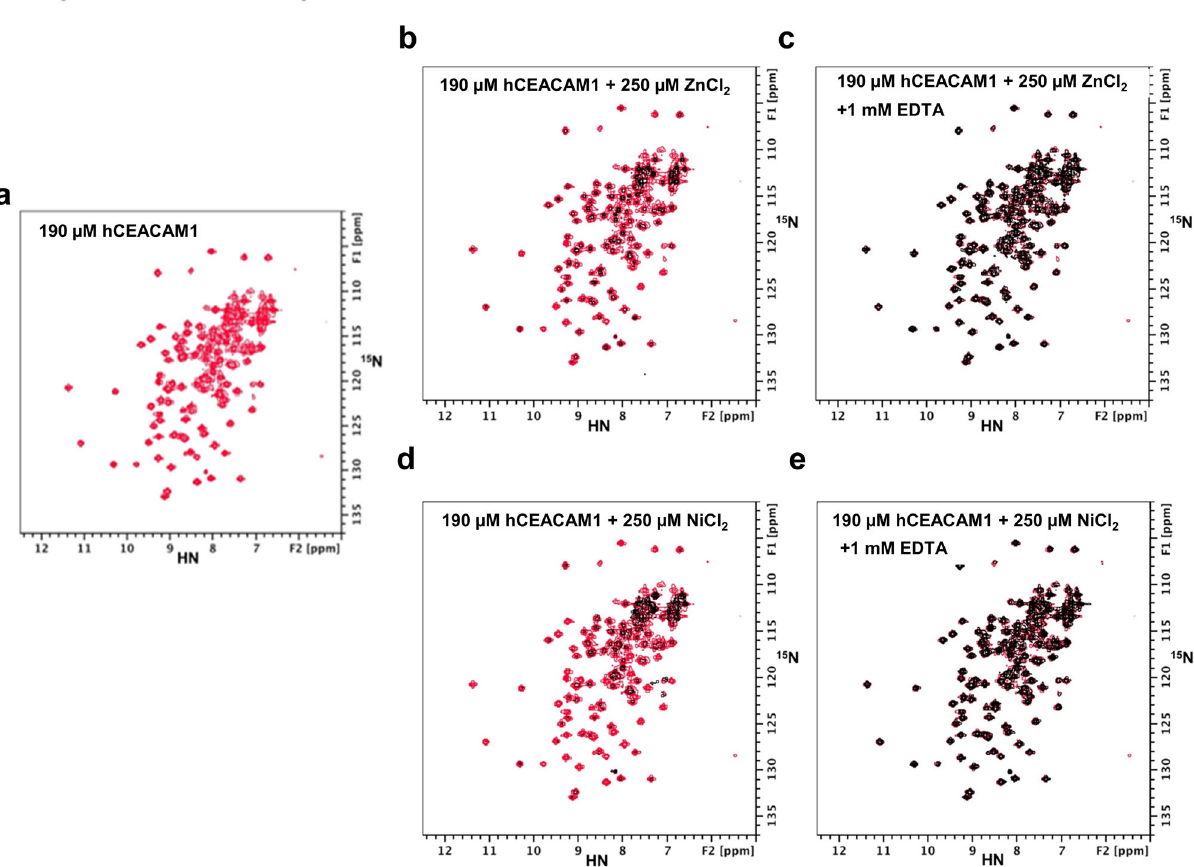
Fig. 7 15 N-HSQC spectra of WT hCEACAM1 IgV domain with zinc chloride (ZnCl 2 ) and with nickel chloride (NiCl 2 ) and effect of EDTA. 15 N-HSQC spectra of 190 µ M 15 N-labeled WT hCEACAM1 IgV domain alone (panel a , peaks in red), and in the presence of 250 µ M ZnCl 2 (panel b , weakened peaks in black), and both 250 µ M ZnCl 2 and 1 mM EDTA (panel c , recovered peaks in black). The weakened and missing backbone amide peaks caused by zinc bridging induced oligomerization/aggregation as shown in middle b panel are recovered after addition of EDTA (right c panel) to sequester zinc ions. 15 N-HSQC spectra of 190 µ M 15 N-labeled WT hCEACAM1 IgV domain in the presence of 250 µ M NiCl 2 and 1 mM EDTA (panel e , recovered peaks in black). The weakened and missing backbone amide peaks caused by zinc bridging as shown in middle b panel or nickel bridging as shown in middle ( d ) panel are recovered after addition of EDTA to sequester zinc or nickel Methods Protein expression, 15 N labeling/culture preparation, refolding and puri fi ca- tion . hCEACAM1 IgV domain protein expression and puri fi cation were done mostly following our previously published protocols 7,9 . For unlabeled hCEACAM1 IgV protein, competent E. coli BL21 (DE3) were transformed with a pET21d vector containing human CEACAM1 IgV gene insert. Transformants were grown in 1L of LB media supplemented with 100 µg/mL of ampicillin and induced with 1 mM IPTG after reaching an OD600nm of 0.8 at 37 °C. Next, the cultures were grown 4 more hours before harvesting cell pellets by centrifugation. For 15 N-isotopic labeling of human CEACAM1 IgV, M9 minimal media containing 42 mM Na 2 HPO 4 , 22 mM KH 2 PO 4 , 8.6mM NaCl, 0.1% 15 N-NH 4 Cl (Cambridge Isotope